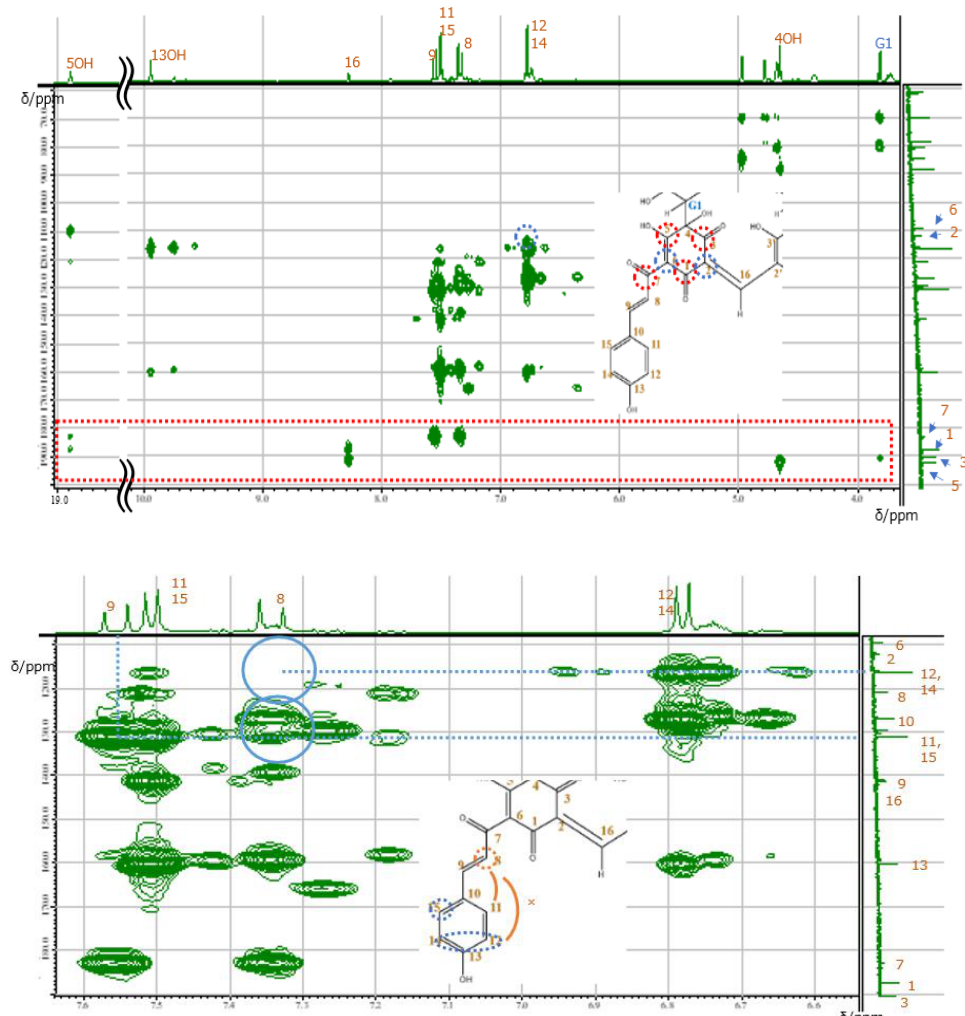
Figure 8. Full-range ( top ) and expanded ( bottom ) HMBC spectra of carthamin potassium salt recorded in DMSO-d6 at 30 °C.